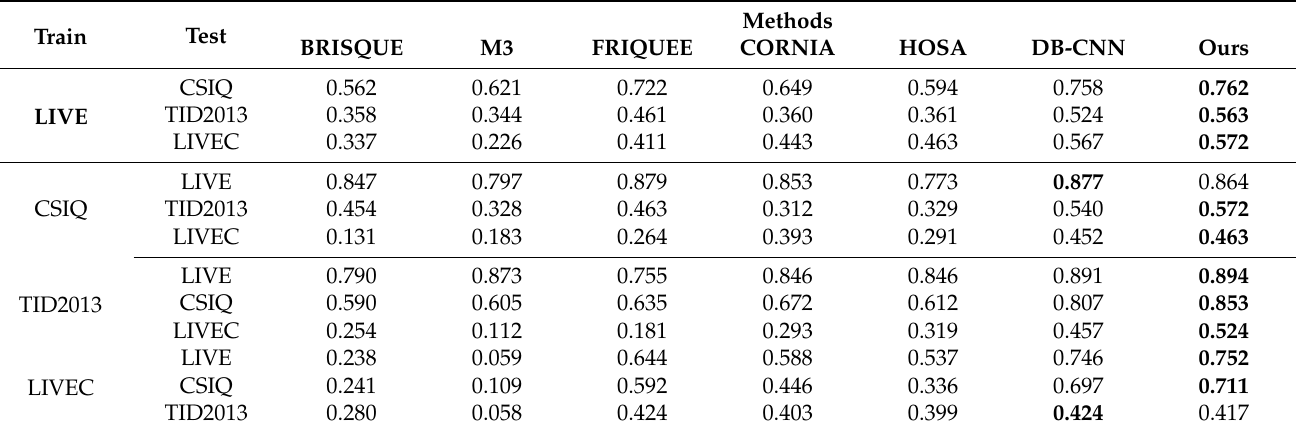
Table 5. SRCC evaluations on cross database tests. The top-performing method is highlighted in boldface.